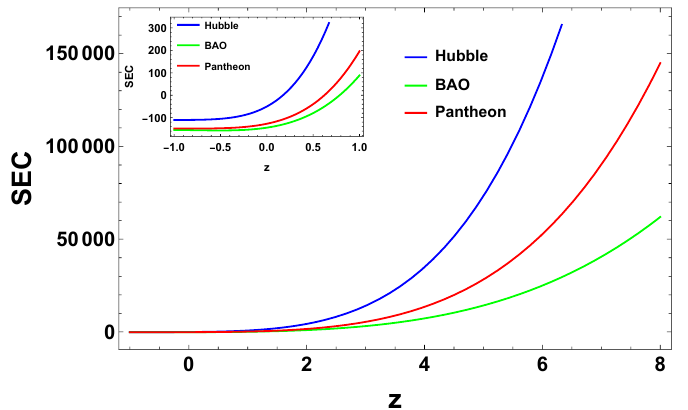
Figure 11. Profile of the strong energy condition for the given model corresponding to the values of the parameters constrained by the Hubble, BAO, and Pantheon data point